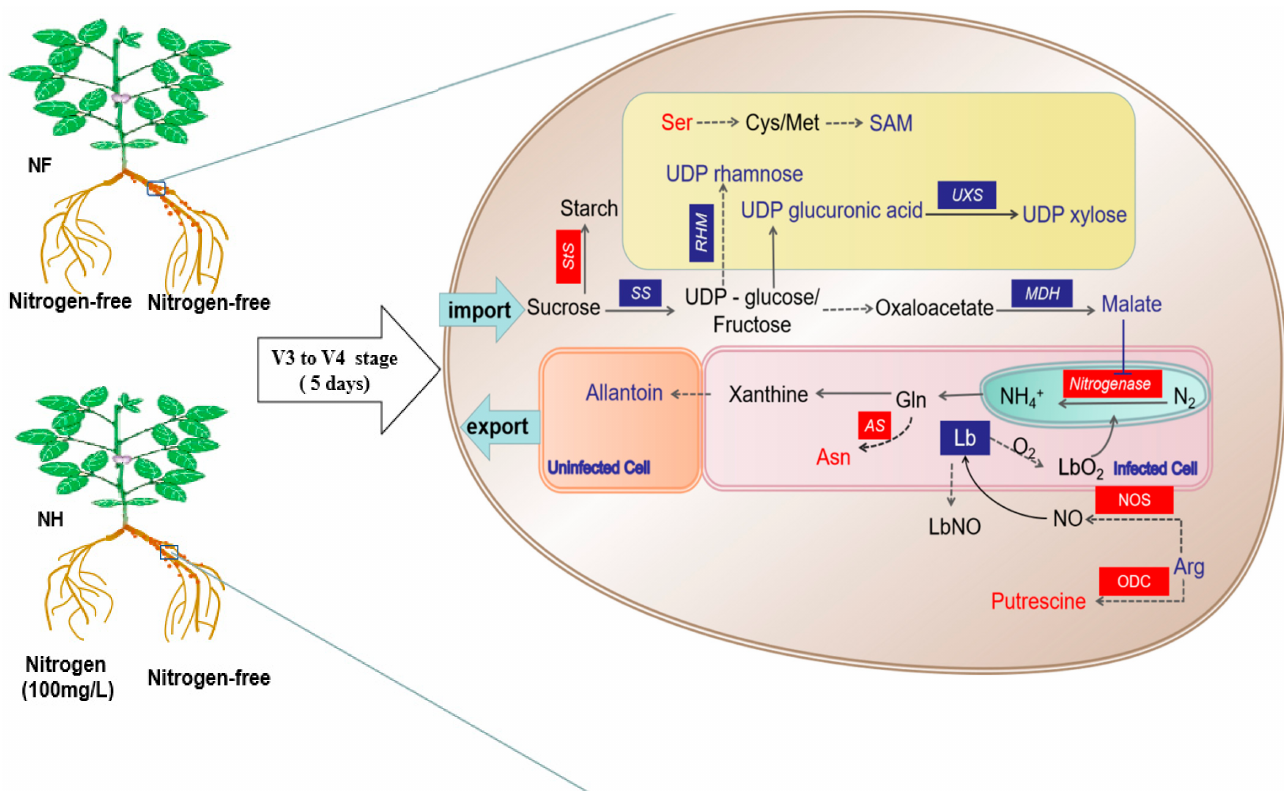
Figure 9. DEPs and DEMs associated with the pathway of nitrogen-regulated pathway in